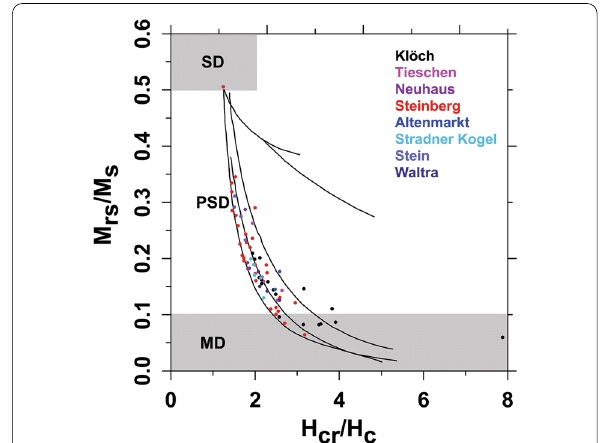
Fig. 3 Hysteresis parameters (ratio of saturation magnetizations vs ratio of coercivity) plotted in a Day-diagram (Day et al. 1977)